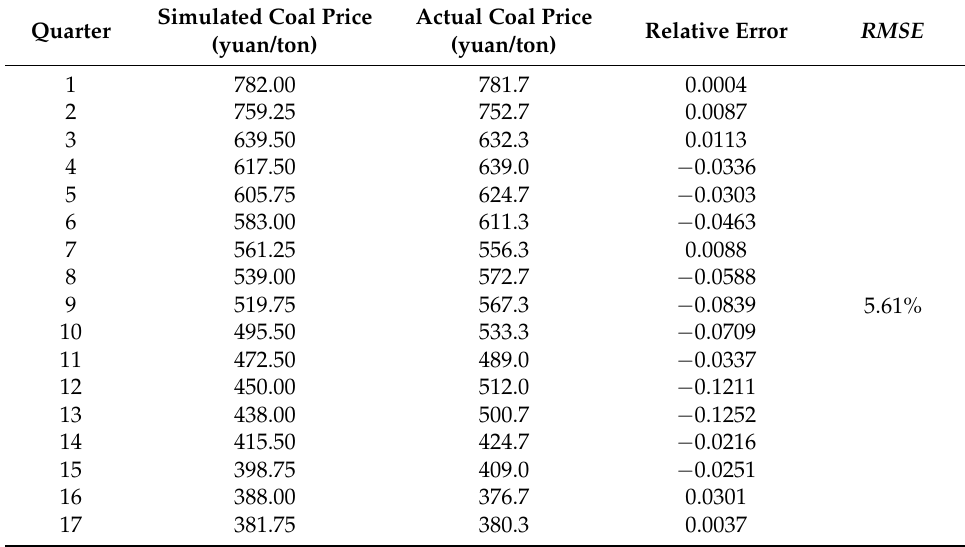
Table 3. Root mean square error ( RMSE ) analysis result of simulated coal price and actual coal price.